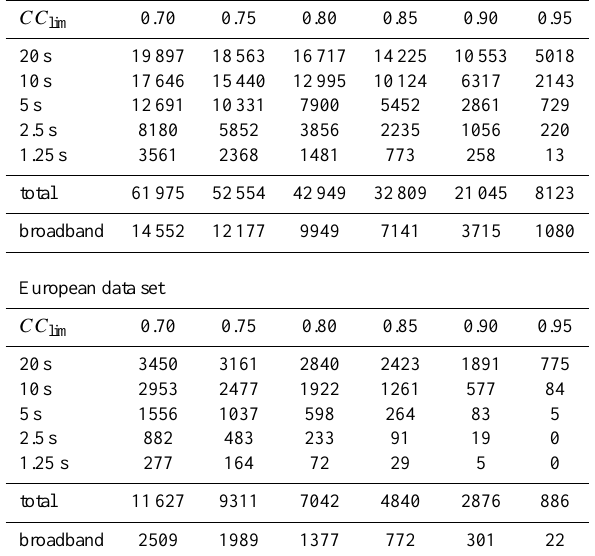
CC lim . In total 26016 (NA) and 4916 (Europe) broadband seismo-